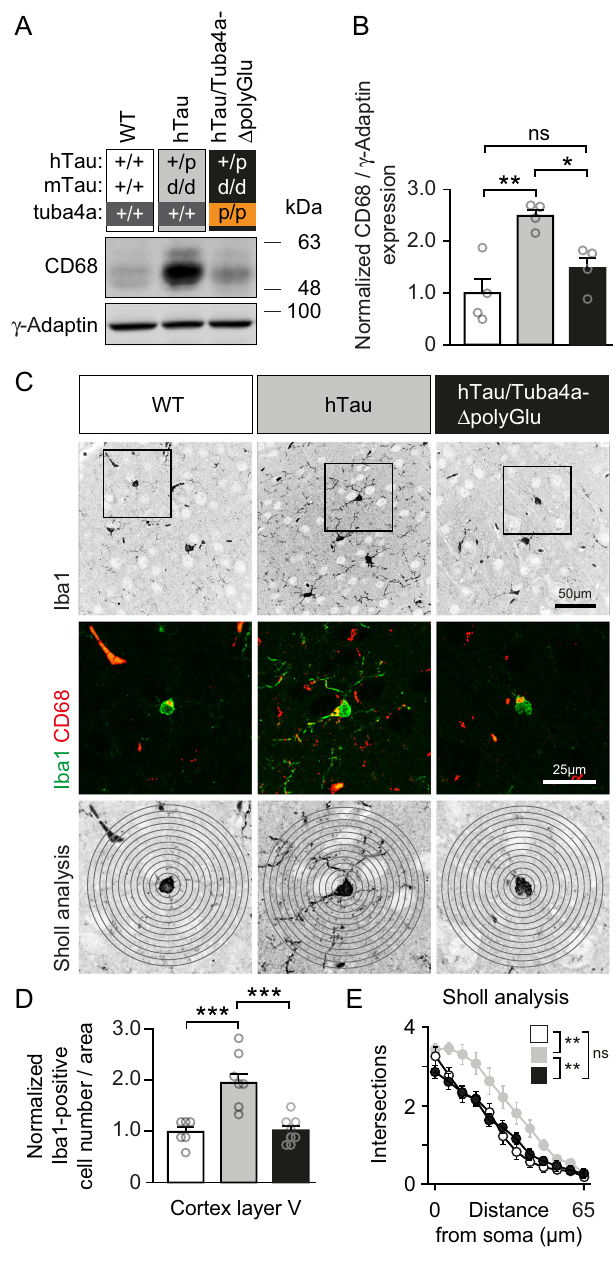
Fig. 9 Microglia activation and expansion in a tauopathy mouse model is normalized upon the loss of Tuba4a C-terminal polyglutamylation. A Western blot analysis of CD68 (marker for activated microglia) in cortical lysates derived from 12-month-old Tuba4a (WT) and Tuba4a Δ polyGlu mice crossed with a tauopathy mouse model (hTau ( + /p)). Wild-type mice not expressing hTau, served as controls. B CD68 signal intensities normalized to γ -Adaptin, shown in ( A ). Tuba4a (WT) set to 1; n = 4 mice per genotype. C Iba1-positive cells (marker for microglia), in cortical brain sections derived from 12-month-old Tuba4a 2.0 (WT) and Tuba4a Δ polyGlu mice, crossed with hTau ( + /p) mice. Wild- type mice not expressing hTau, served as controls. Upper panels: Iba1 1.0 (greyscale) within layer V, scale bar, 50 µ m. Middle and lower panels: o r magni fi cation of boxed regions in upper panels; Iba1 (green), CD68 (red); 0 N scale bar, 25 µ m. Lower panels: Sholl analysis with 6 µ m intervals (circles). D Normalized cell number of Iba1-positive cells per area analyzed in cortical layer V. n = 6(WT), 8( + / + and p/p) per genotype. E Quanti fi cation of Sholl analysis: the number of microglia branch intersections that occur from the soma in concentric circles was analyzed. Higher values re fl ect complex microglia processes, indicating activated microglia. Note that gliosis, as detectable in hTau cortical sections, is signi fi cantly reduced in the background of Tuba4a Δ polyGlu, as compared to Tuba4a (WT). n = 6(WT), 8( + / + and p/p) per genotype. Two-sided one-way ( B , D ) or two-way ( E ; genotype × distance) ANOVA was used to assess statistical signi fi cance. * p < 0.05, ** p < 0.01, *** p < 0.001. Data represent mean ± SEM. Source data, including exact p -values, are provided as a Source Data fi